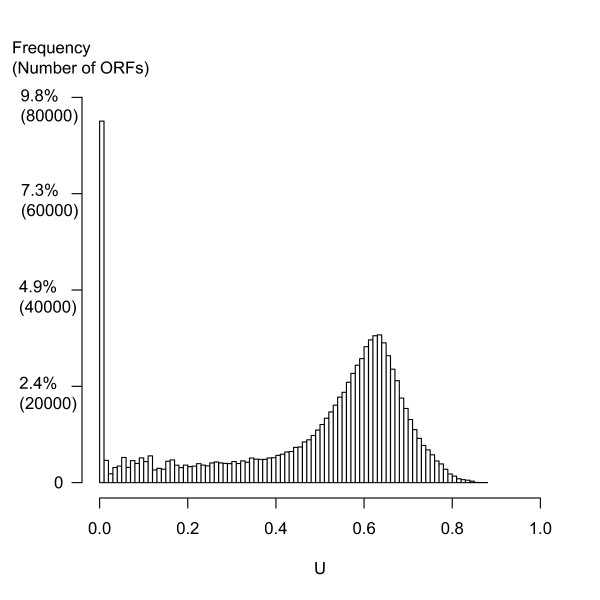
U-value histogram for all the 818,906 ORFs in 277 prokaryote genomes. The U-value is a measure of the "conservation" of each ORF (see Methods); U = 0 means the ORF is unique to one single organism, i.e. a singleton or paralogous ORFan. 9.1% of all ORFs have U = 0. The left tail 0.0 < U <= 0.1 (4.3% of all ORFs) corresponds to orthologous ORFans, ORFs with homologs only in closely related organisms. Notice the uneven distribution of U, with its long left tail and the very high peak at U = 0.